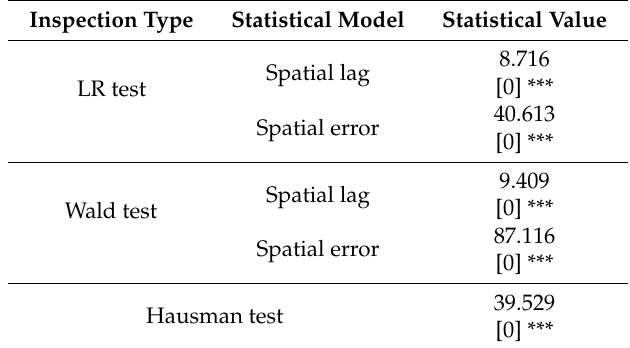
Table 4. The results of LR, Wald, and Hausman tests in the spatial panel data